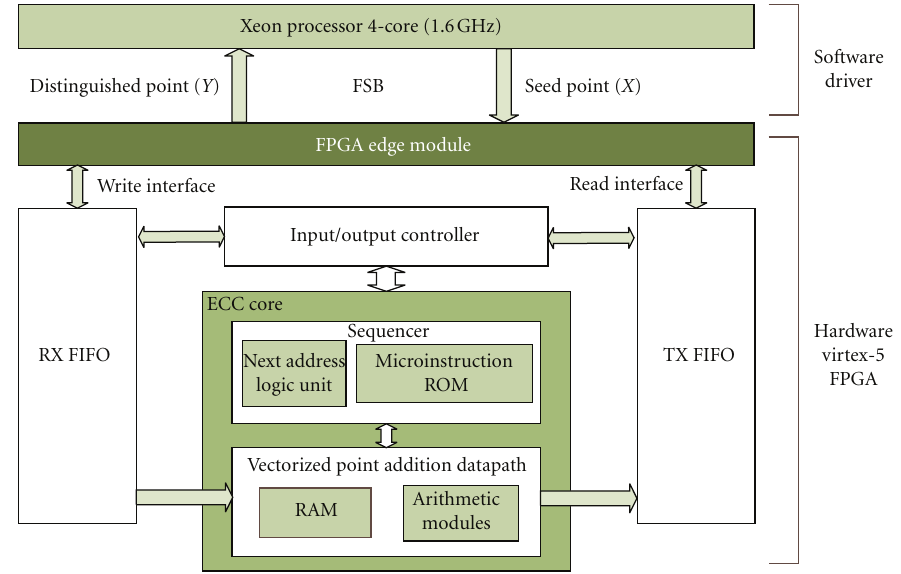
Figure 6: System